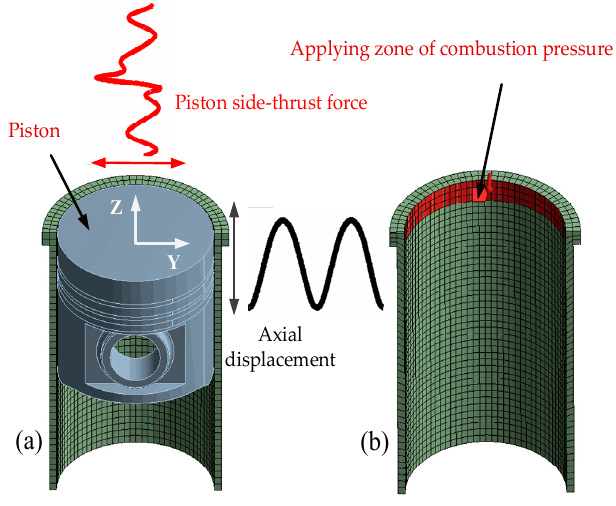
Figure 5. Excitation configurations of cylinder model; ( a ) Piston slap; ( b ) Combustion shock.